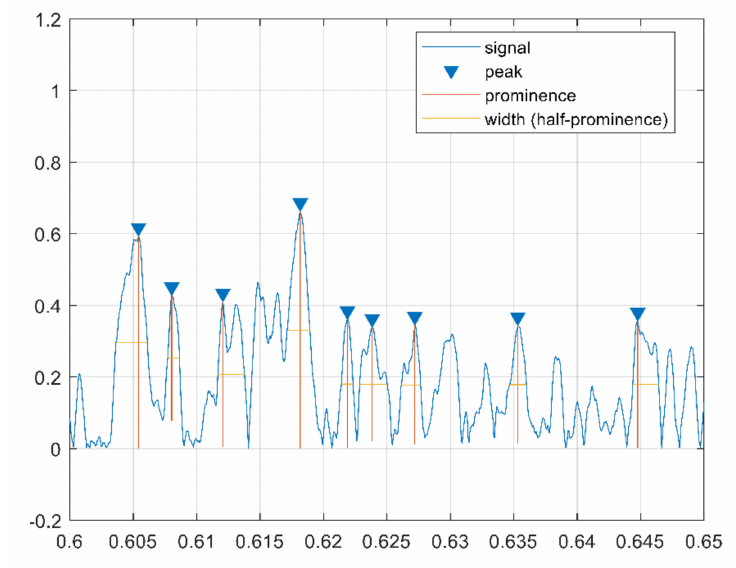
Figure 6. Cepstrum peak features for corrugated